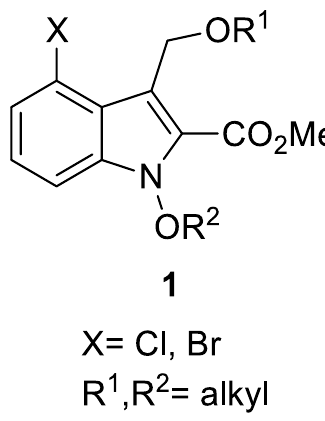
Figure 2. Structures of multisubstituted 1-alkoxyindoles 1 .